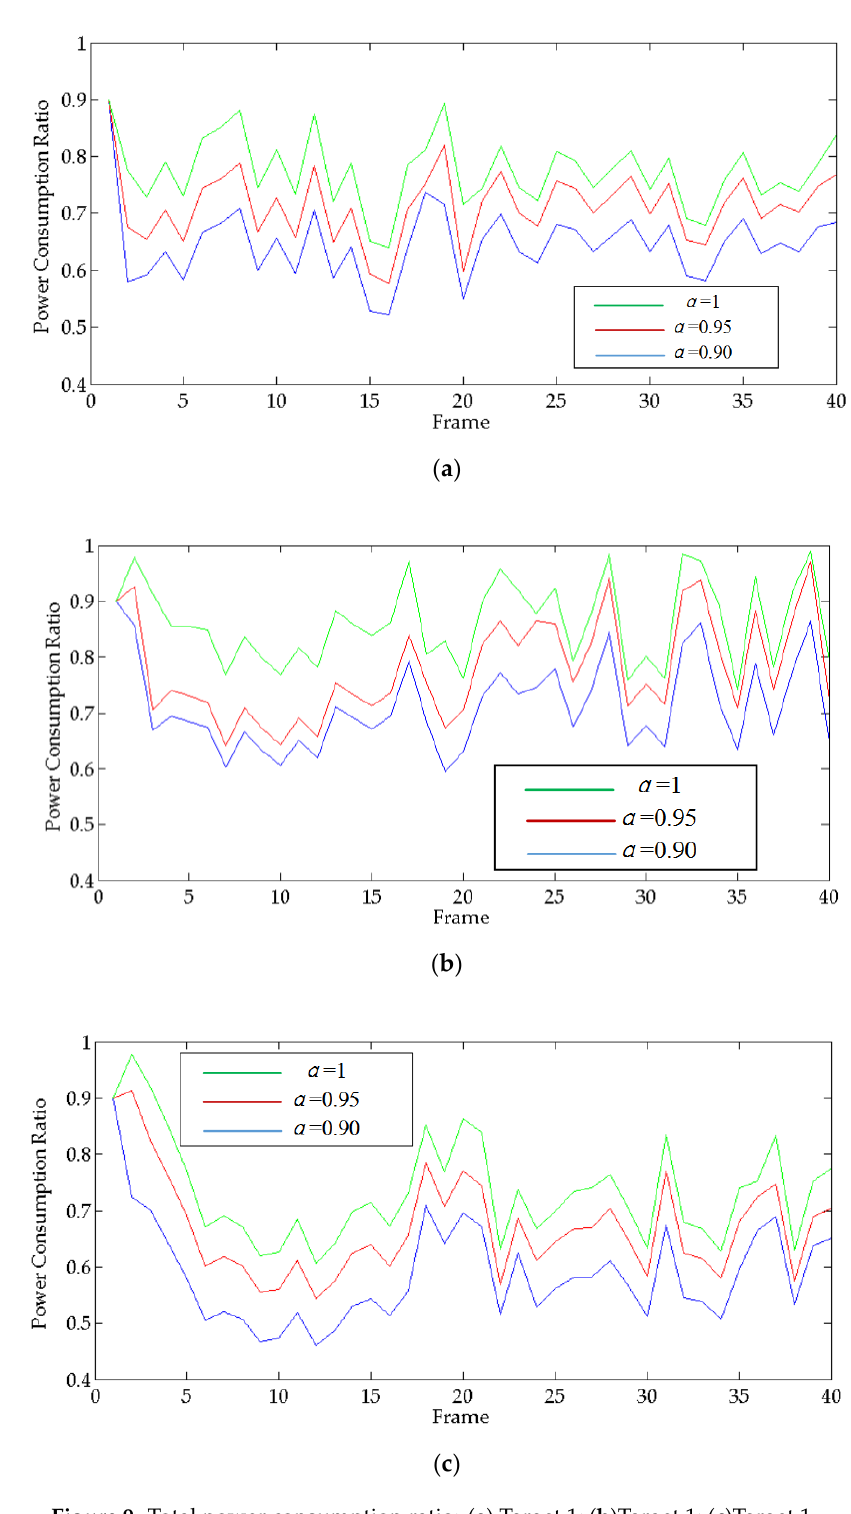
Figure 9. Total power consumption ratio: ( a ) Target 1; ( b )Target 1; ( c )Target 1.